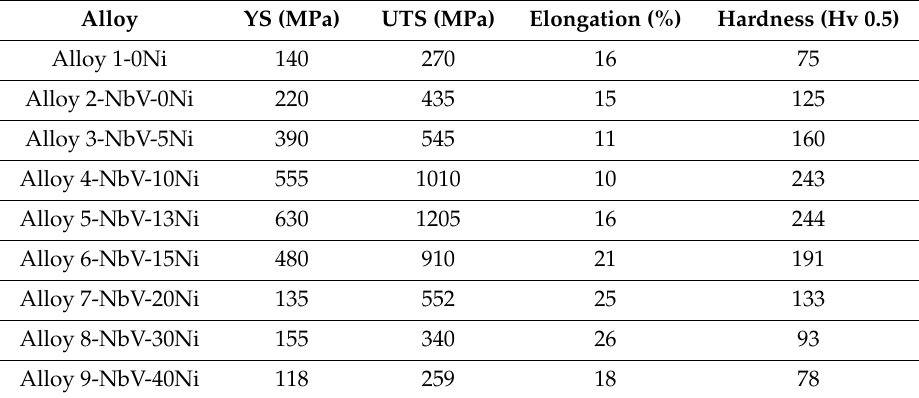
Table 2. Mechanical properties of the